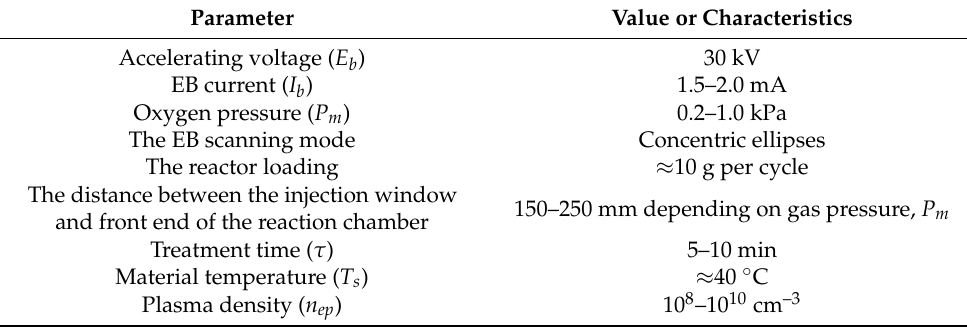
Table 1. The conditions of the chitosan